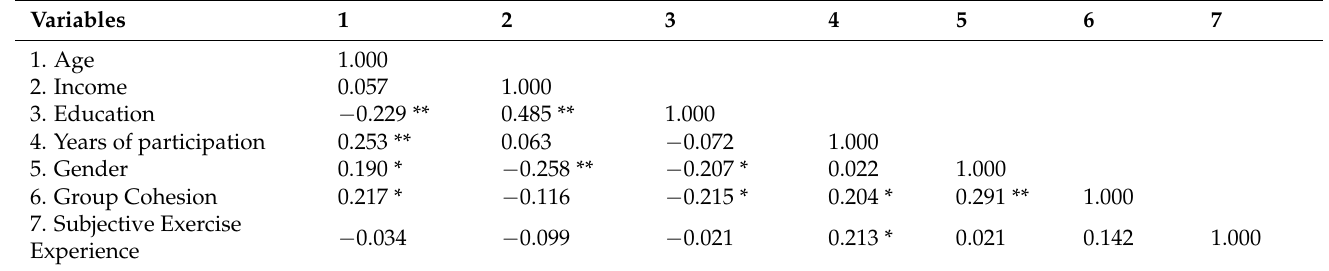
Table 5. Pearson correlations between demographic information, Group Cohesion, and Subjective Exercise Experience (N = 63 +